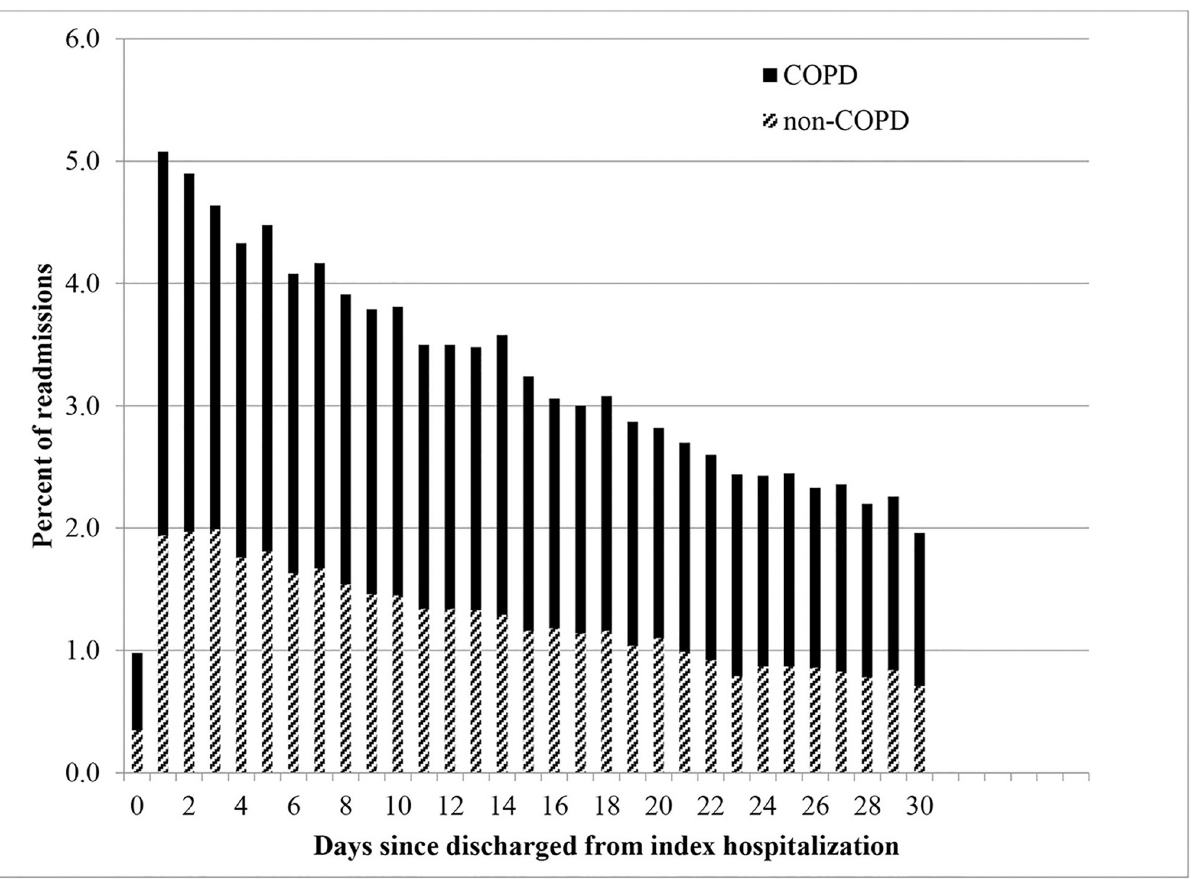
Fig 3. Time to readmission for patients readmitted after a hospitalization for COPD by cause of